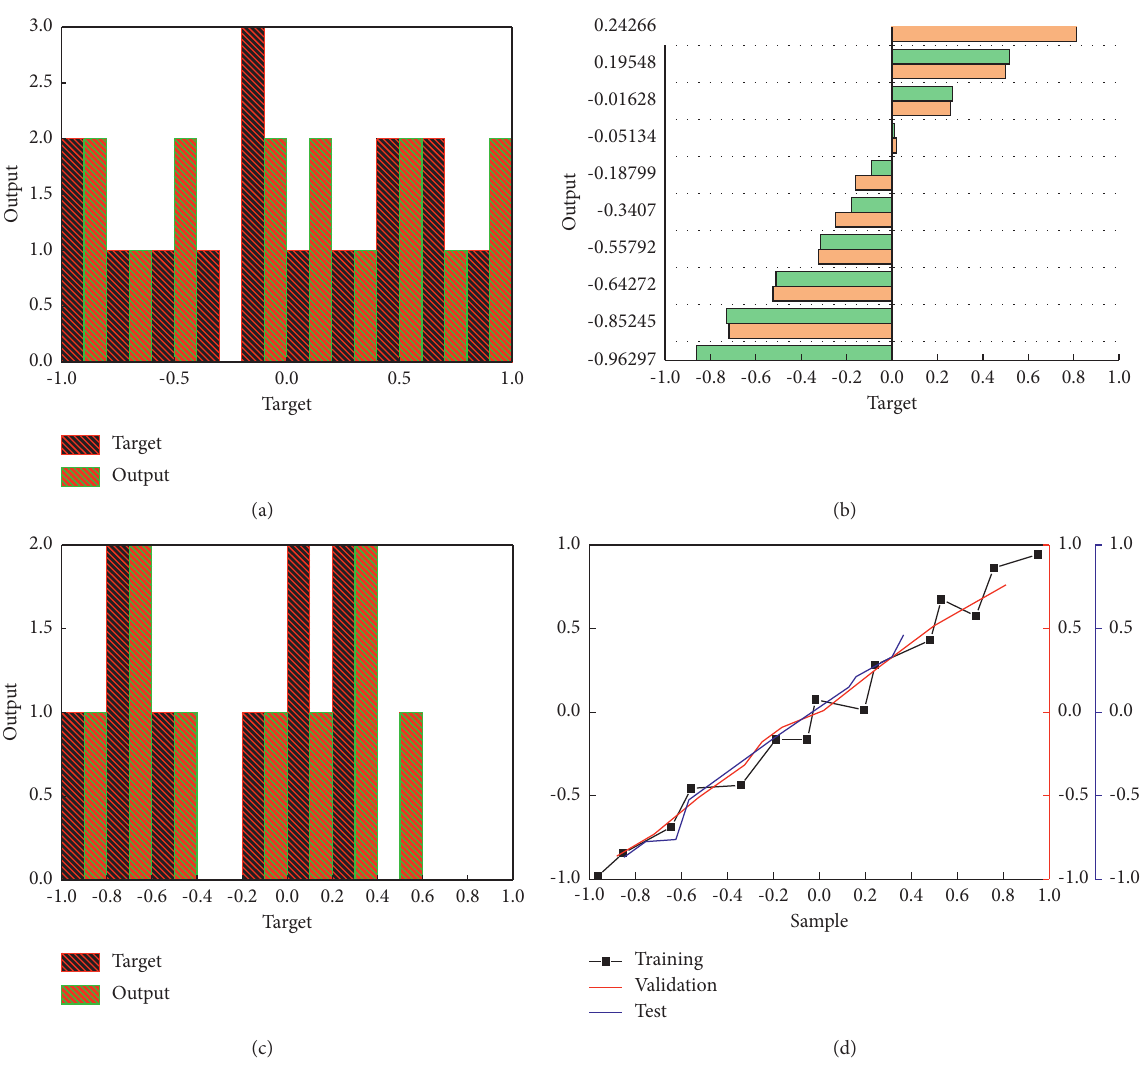
Figure 5: Regression analysis of training. (a) Training, (b) validation, (c) test, and (d) all.